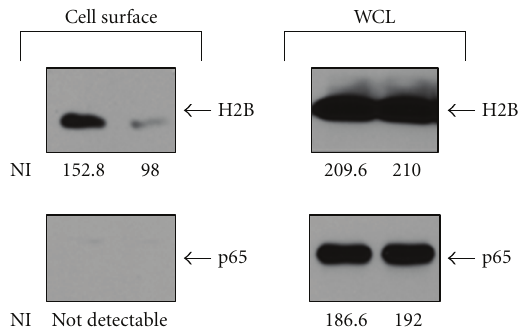
Figure 1: H2B exposure on the surface of endothelial cells. Human umbilical vein endothelial cells (HUVECs) were either untreated or treated with annexin V (250nM) for 48hr. Cells were surface labeled with biotin, and the biotinylated proteins were isolated using streptavidin-conjugated beads. H2B and p65 (a transcription factor with a cytosolic and nuclear localization) that were bound and eluted from the streptavidin beads were detected by western blotting with a rabbit anti-H2B or rabbit anti-p65. The absence of biotinylated p65 serves as a control for surface labeling of H2B. Band intensities of the western blots were analyzed using Kodak ID 3.6 software, and net intensity (NI) of each band is indicated below each lane. In each set of two lanes, the right-hand lane is in the presence of annexin V and the left-hand lane in its absence. (WCL: whole cell